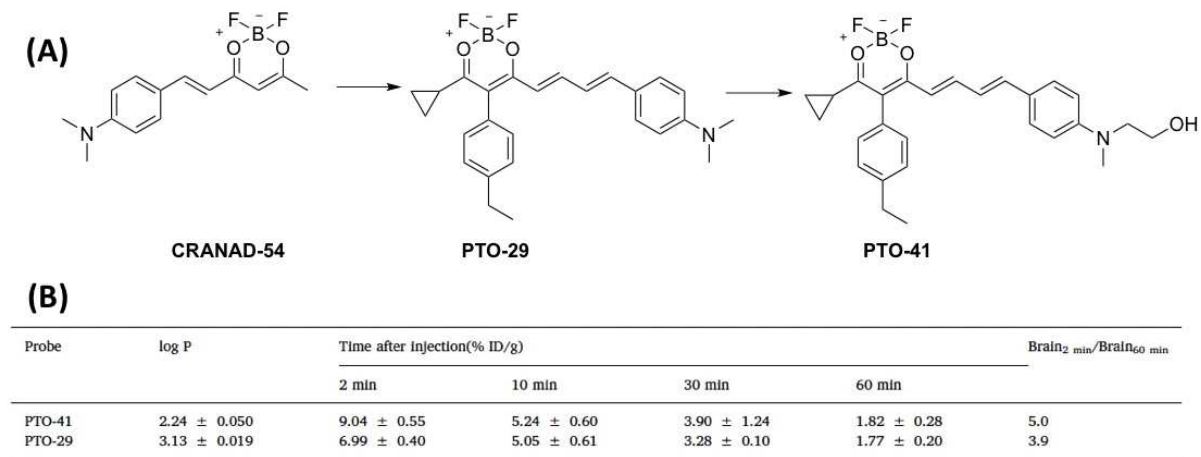
Figure 5. ( A ) The chemical structures of CRANAD−54, PTO−29, PTO−41 and AD−1; ( B ) Log p values and the brain uptake (%ID/g) of PTO−29 and PTO−41 at different time points. These curcumin analogues can detect Aβs in vitro and in vivo; however, the probes always have low quantum yield (QY). Ran et al. substituted the phenyl rings with pyra- zoles to improve the brightness of these probes in order to overcome their low QY limita- tion [59,69]. CRANAD-28 has a high QY (Φ = 32%) in PBS as expected. The result showed that CRANAD-28 is a good two-photon imaging probe which can detect Aβ plaques and cerebral amyloid angiopathies (CAAs) (Figure 6A), but it is not suitable for in vivo NIRF imaging due to its short emission wavelengths (578 nm). In addition, Yang et al. reported AD-1 by incorporating 2-aminoethyl diphenyl borate (DPBA) as a stabilizer into the cur- cumin scaffold to improve stability and BBB penetration ability [60]. AD-1 has an emission wavelength of 704 nm and can monitor all Aβ forms. Furthermore, it was successfully used to image 4-month-old APP/PS1 mice in vivo studies (Figure 6B,C).